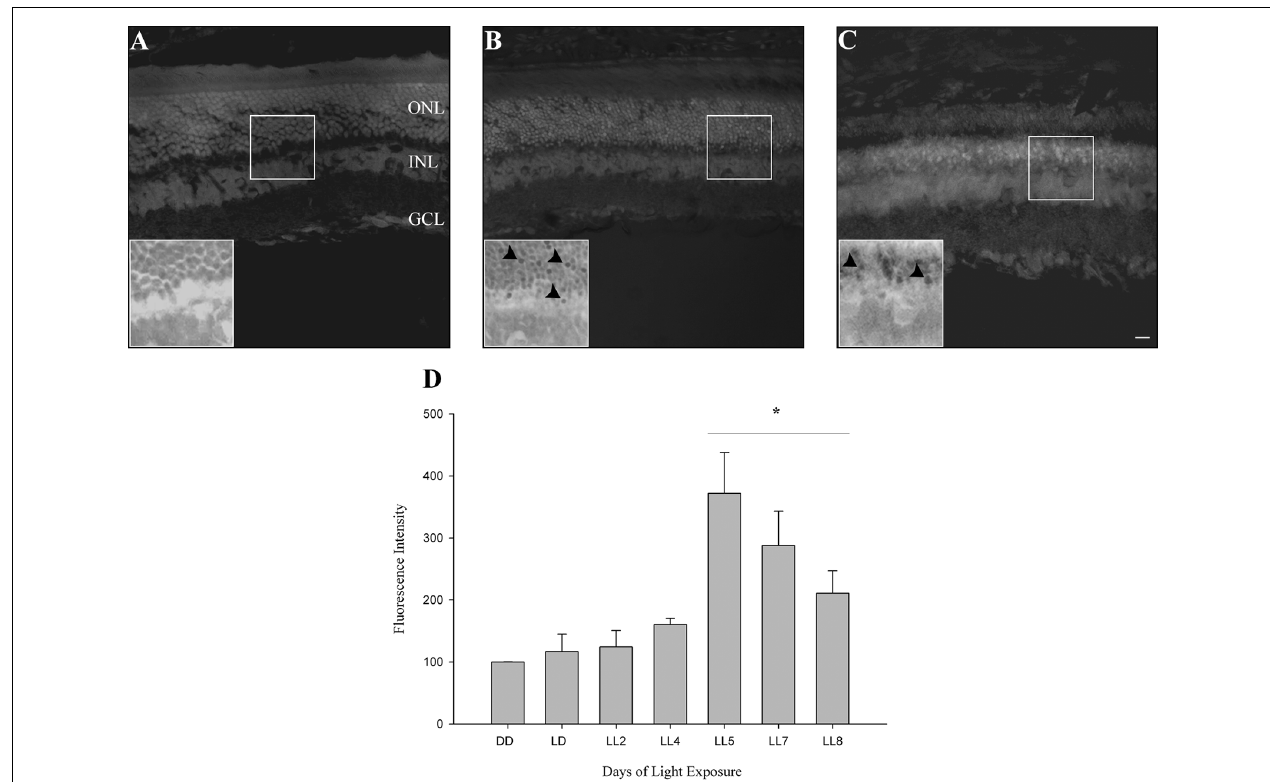
FIGURE 2 | Oxidative stress study. (A–C) DHE staining at DD, LL2 and 8 days of light-emitting diode (LED) light exposure. Arrowheads show DHE positive cells in the ONL. (D) Reactive oxygen species (ROS) production detection by Flow cytometry using the DCFH-DA probe in controls (DD and LD) and in animals exposed to 2, 4, 5, 7 and 8 days to constant light (LL2–8). Data are mean ± SE, n = 1 animal/group from three independent experiments, ∗ p < 0.05 vs. DD by Kruskal Wallis. ONL, outer nuclear layer; INL, inner nuclear layer; GCL, ganglion cell layer. Scale bar indicates 30 µ